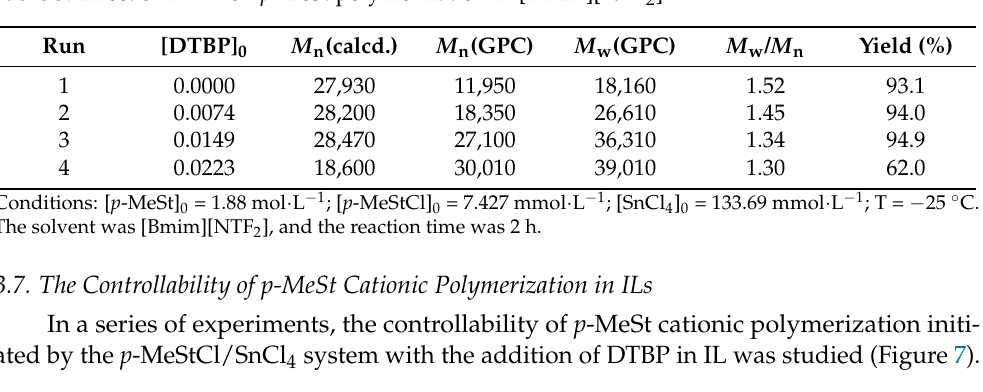
Table 3. Effect of DTBP on p -MeSt polymerization in [Bmim][NTF 2